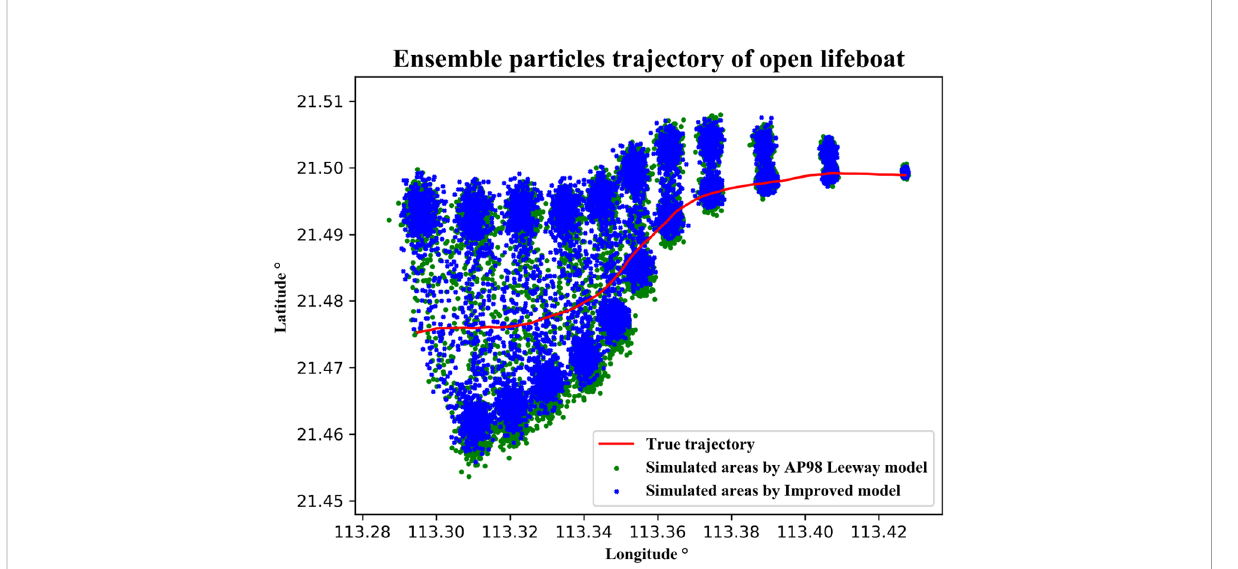
FIGURE 13 Monte Carlo simulation results for Case 1. The random particle distribution of hourly Monte Carlo simulation and the two predicted trajectories after particle averaging. The red line represents the true trajectory, and the two colors of green and black represent the leeway model and the improved model,